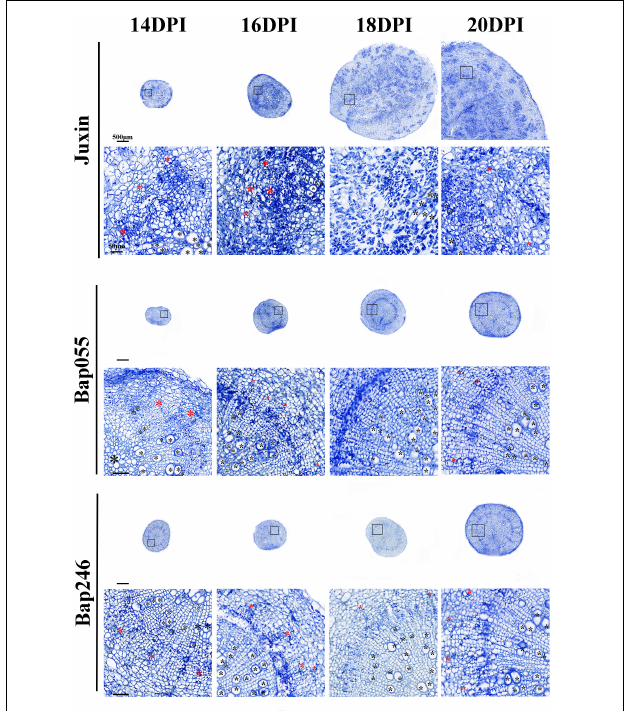
FIGURE 7 | Paraffin root sections of the Chinese cabbage genotypes “Juxin,” Bap055, and Bap246 at 14–20 days post-inoculation (DPI) with P. brassicae . The areas highlighted within the black boxes are enlarged for more detail. Xylem is indicated with black asterisks (*) and phloem is indicated with red